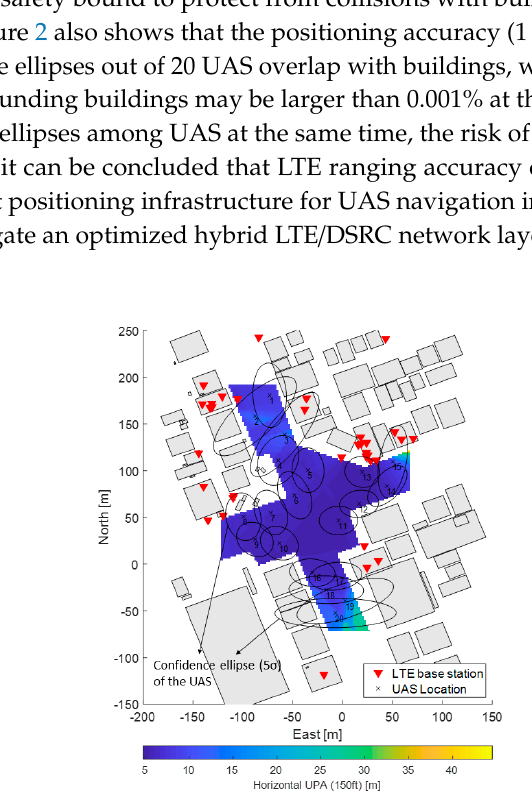
Figure 2. Horizontal positioning accuracy and confidence ellipses (99.999%) of 20 unmanned aircraft systems (UAS) with 35 LTE base stations.